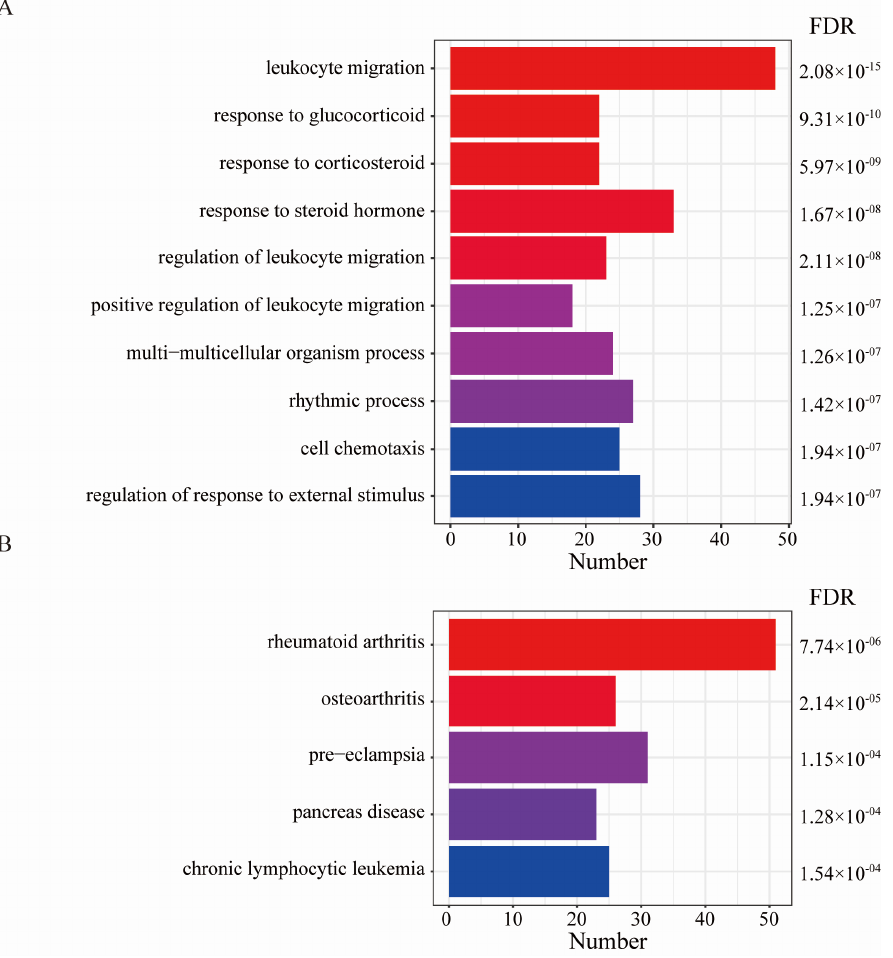
Figure 3. Gene Ontology (GO) and Disease Ontology (DO) enrichment analyses of DEGs. ( A ) GO enrichment analysis, where the horizontal axis represents the number of DEGs under the GO term. ( B ) DO enrichment analysis, where the horizontal axis represents the number of DEGs under the DO term.